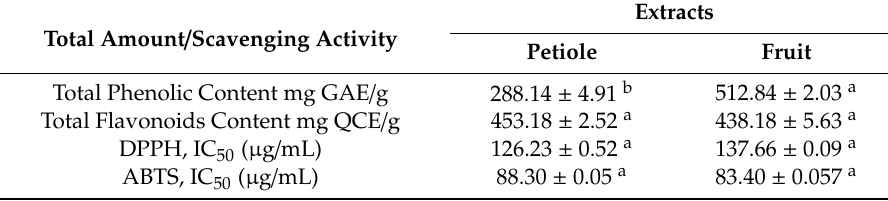
Table 1. Total phenolic and flavonoids content and Antioxidant activity of ethanolic extracts of A. longiloba